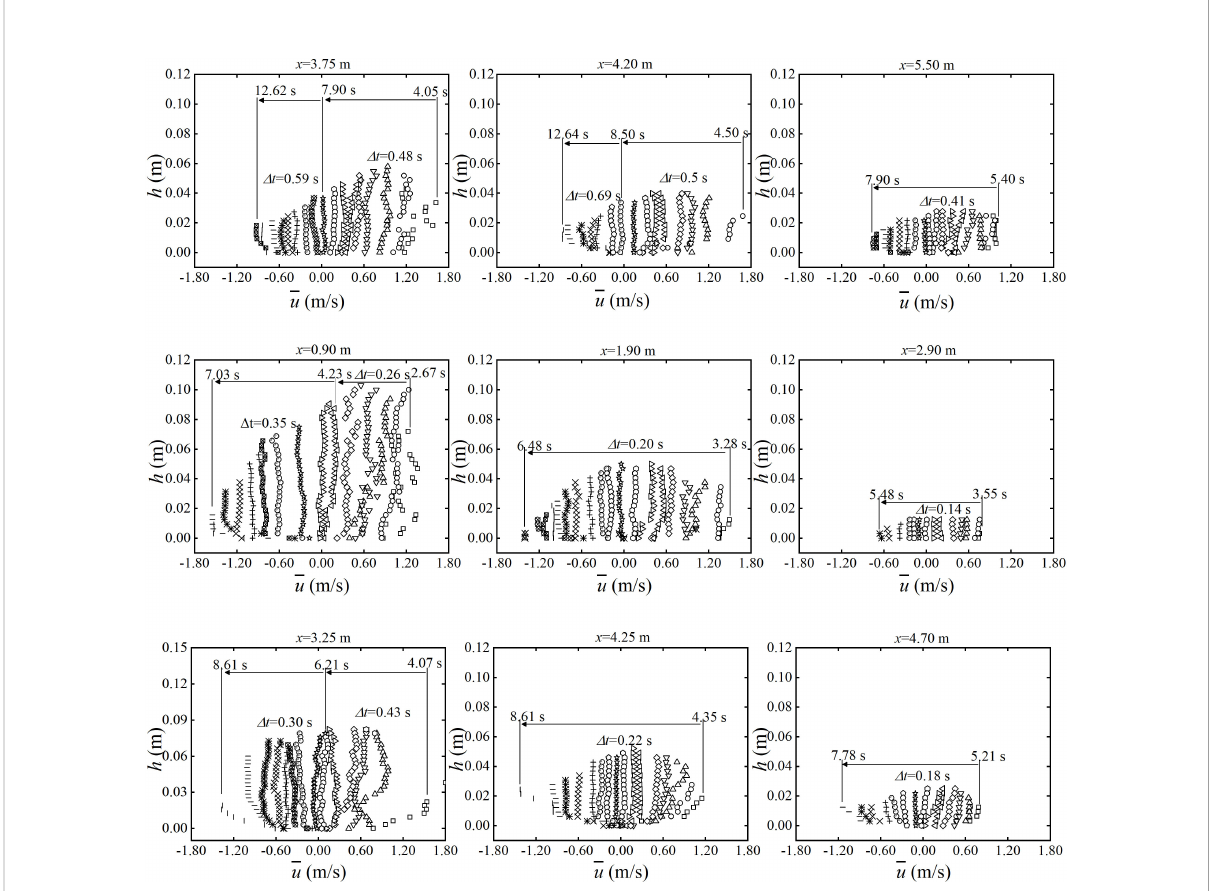
FIGURE 7 Temporal evolution of the ensemble-averaged, cross-shore velocity pro fi les at different cross-shore positions for the three beaches. Upper row: mild beach; middle row: steep beach; lower row: composite beach. In this fi gure, symbols of the same type represent the same pro fi le, and the time interval between two successive pro fi les is D t . Arrows indicate the evolution of pro fi les in